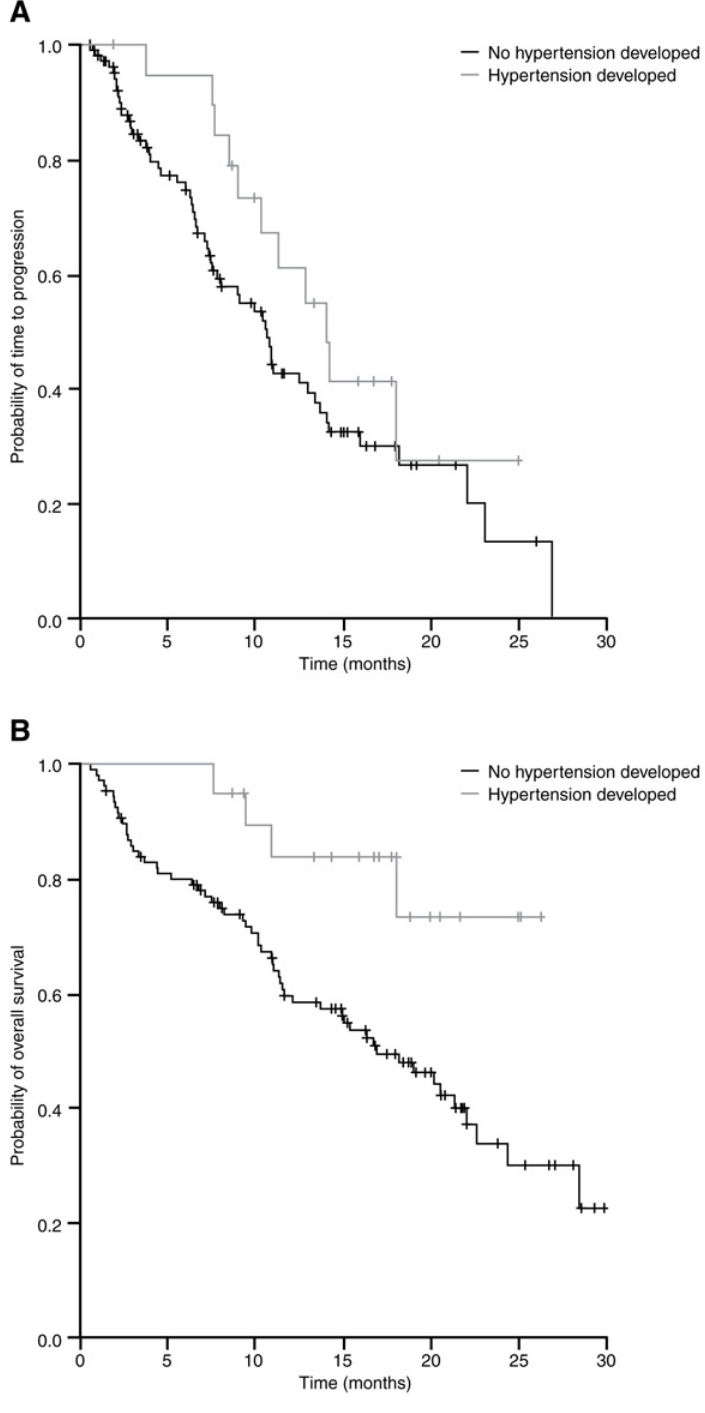
Figure 1. Kaplan – Meier curves of (A) time to progression and (B) overall survival in patients who did and did not develop hypertension during treatment. Patients with hypertension during the study had significantly greater median OS than those with no hypertension. Median TTP was numerically greater in patients with hypertension but this difference did not reach statistical significance.